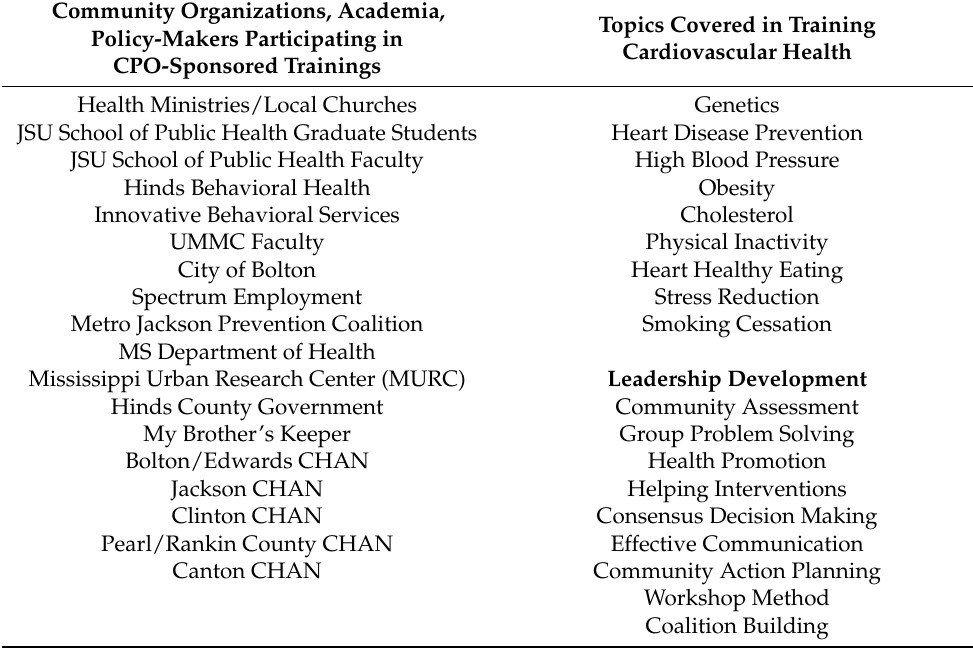
Table 2. Areas of Training for Members of the JHS CHANs and Community